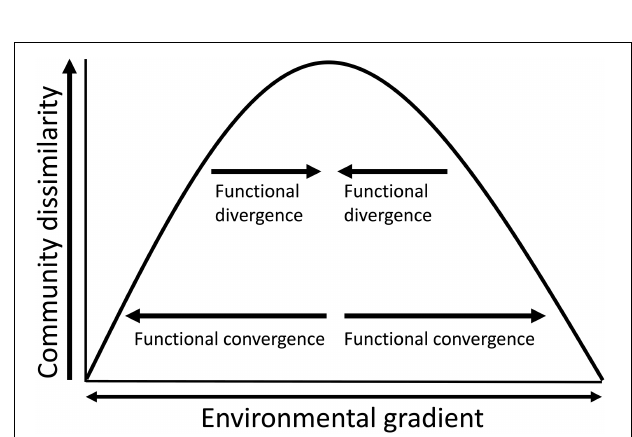
FIGURE 2 | Environmental filtering can be expressed as the relationship between community dissimilarity and environmental gradients. The hypothesized relationship predicts that community dissimilarity decreases toward the more extreme values of an environmental gradient (i.e., strong environmental filtering). Adapted from Muscarella and Uriarte